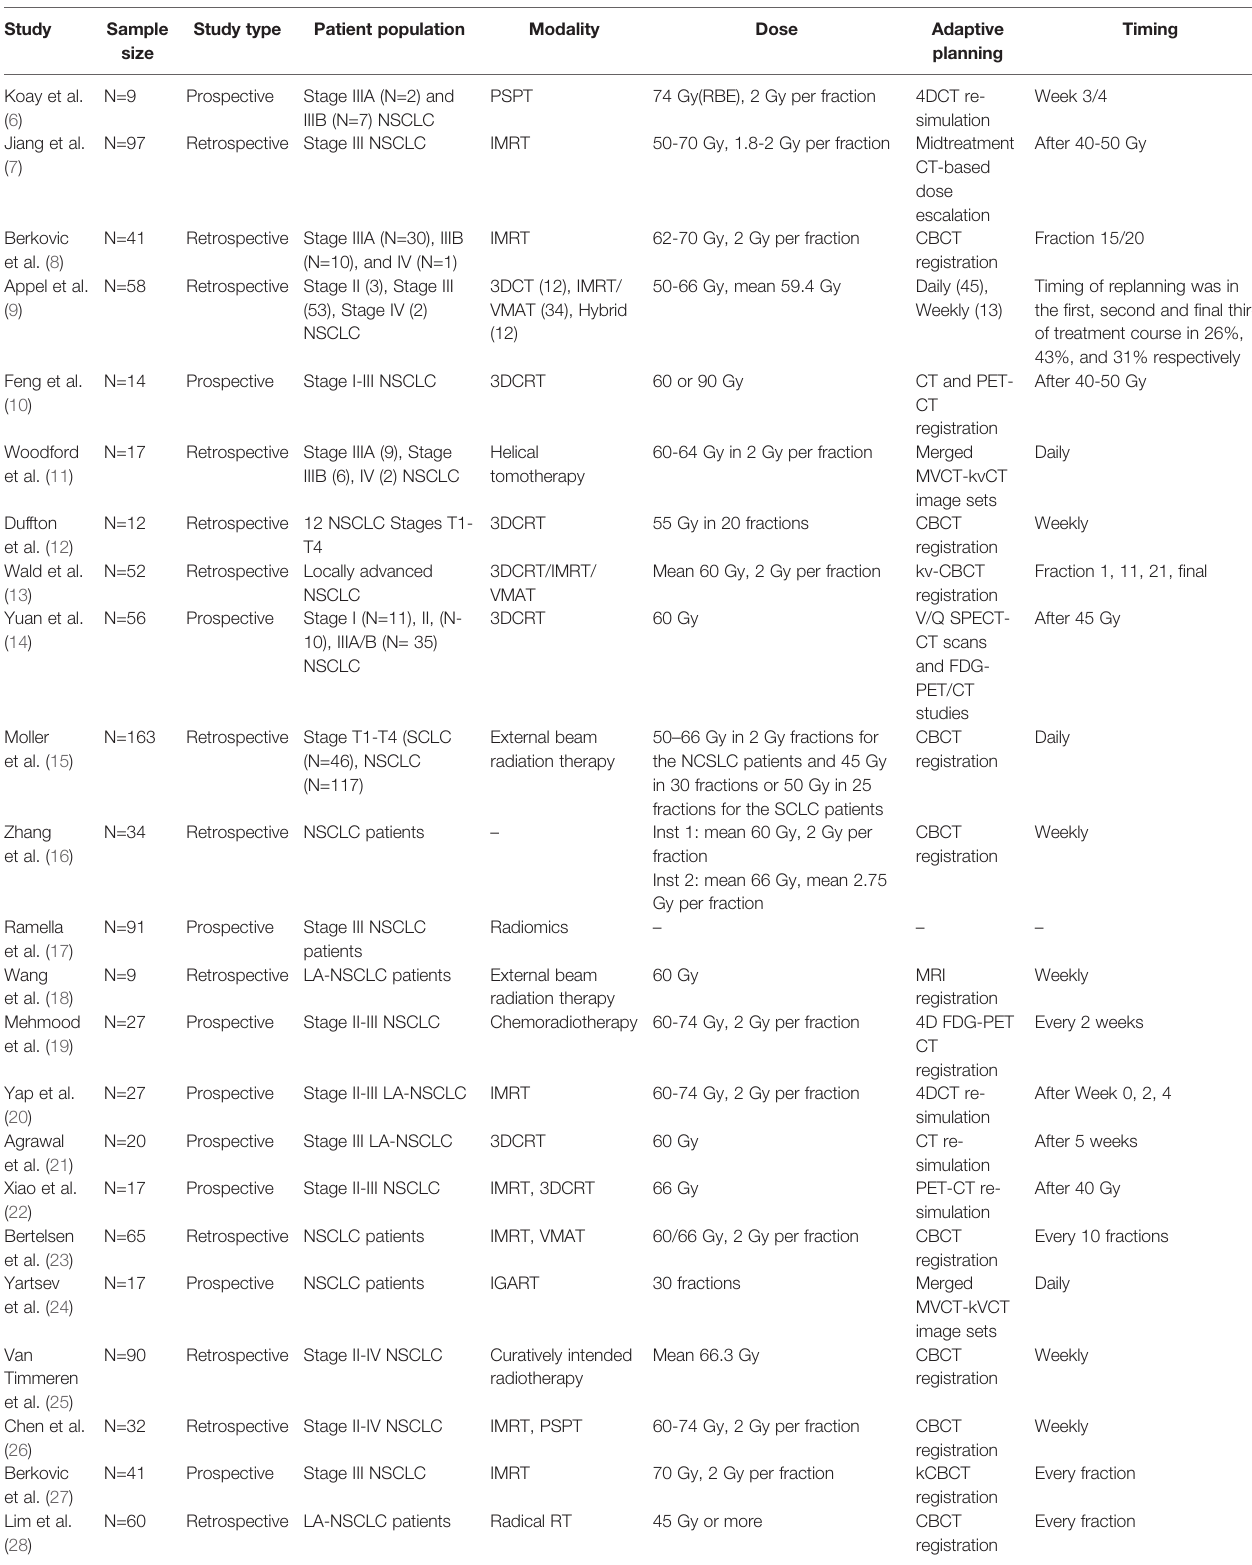
TABLE 1 | Select study characteristics from studies published from 2007-2020 on ART for lung